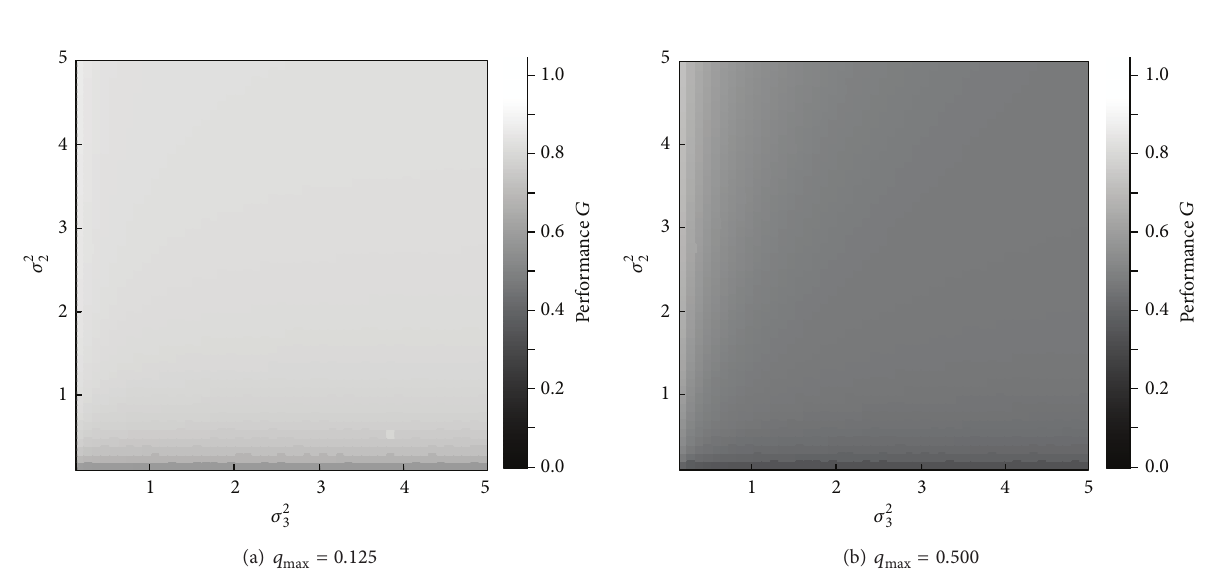
Figure 7: Optimal value of the performance 𝐺